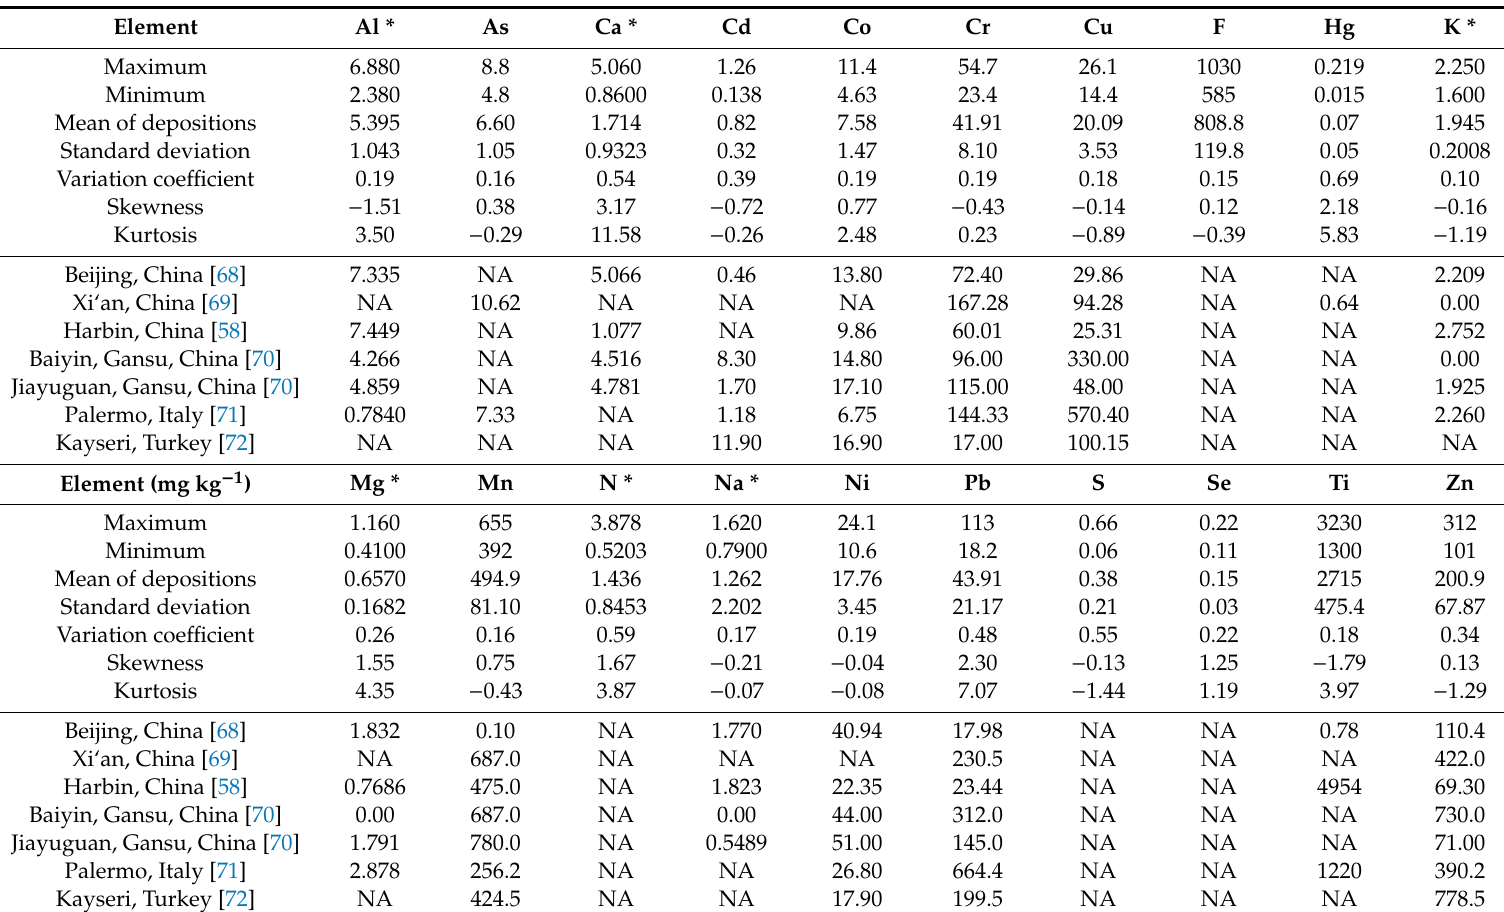
Table 1. Trace and major element contents in atmospheric deposition in this study and in selected Chinese and overseas cities in the literature (n = 17) (mg / kg).